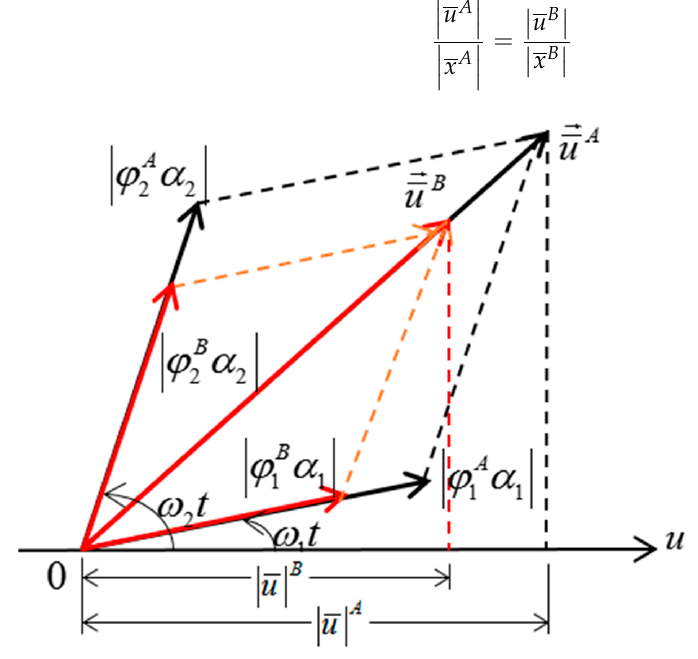
Figure 2. The diagram of the collinear synthesis motions by two modes.